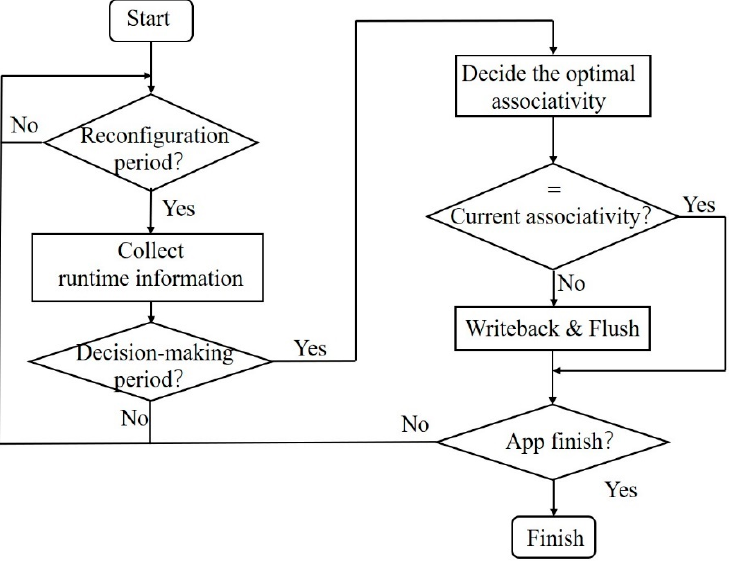
Figure 5. Adaptive control workflow.